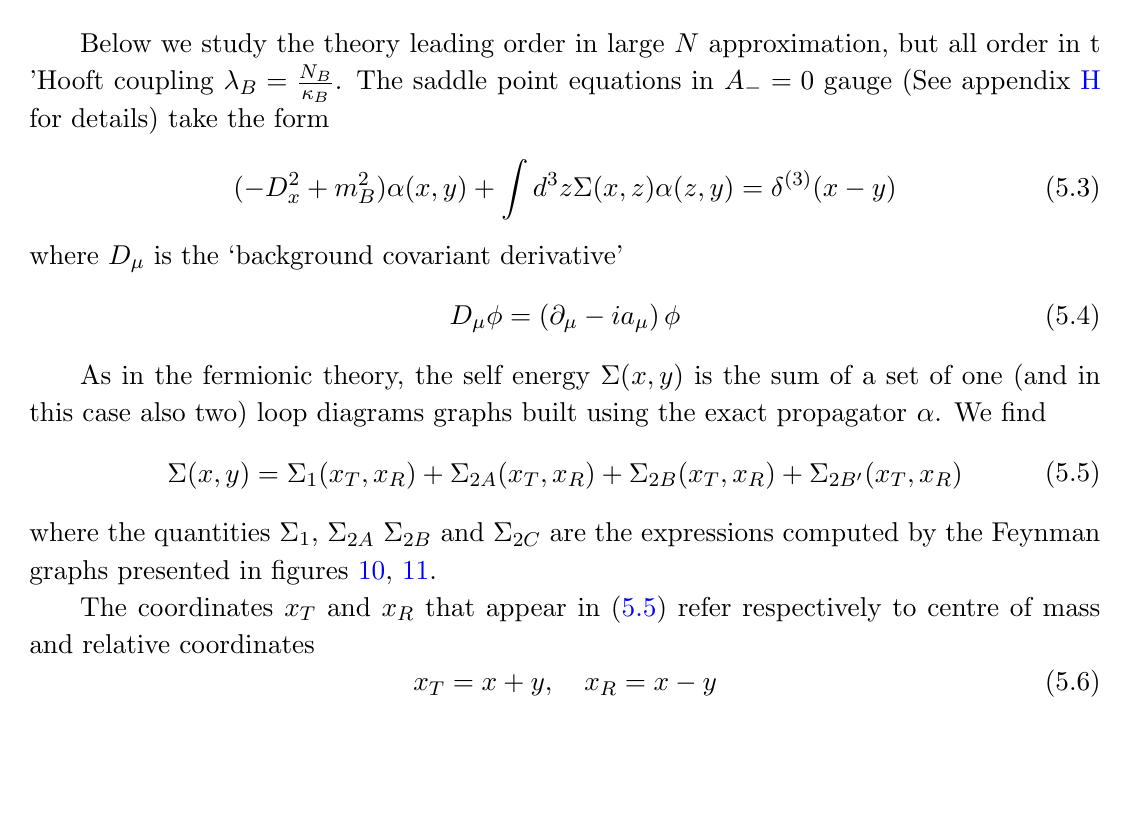
Figure 11. The remaining two ‘two loop’ graphs that contribute to the bosonic self energy. The two graphs above contribute identically in the b = 0 limit, but are distinct at nonzero b . While each of the graphs drawn above is individually complicated, their sum turns out to be relatively